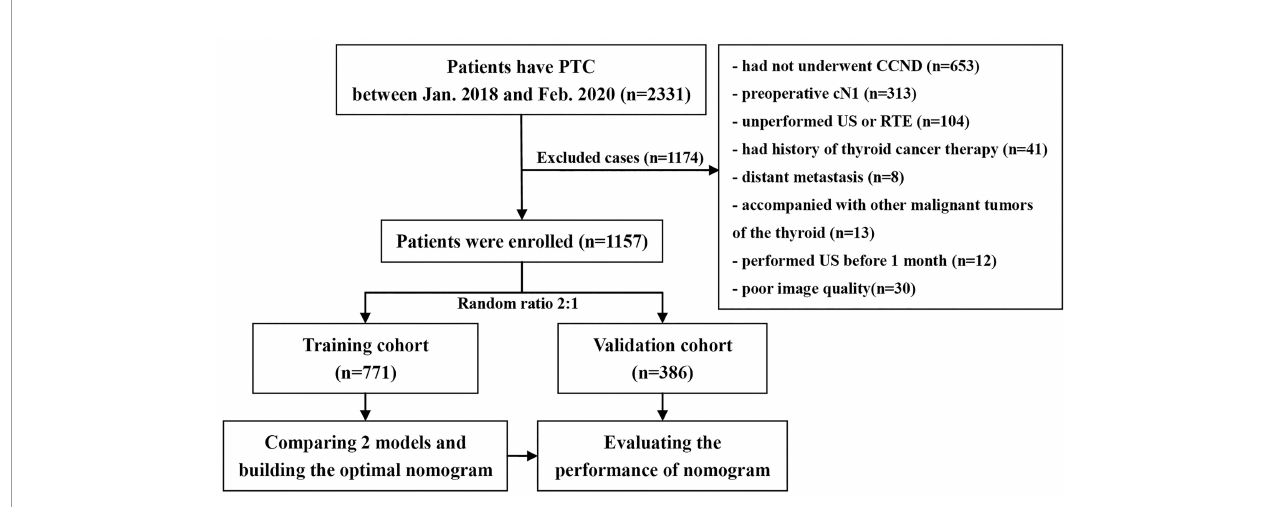
FIGURE 1 | Flowchart of enrolled cN0 papillary thyroid carcinoma